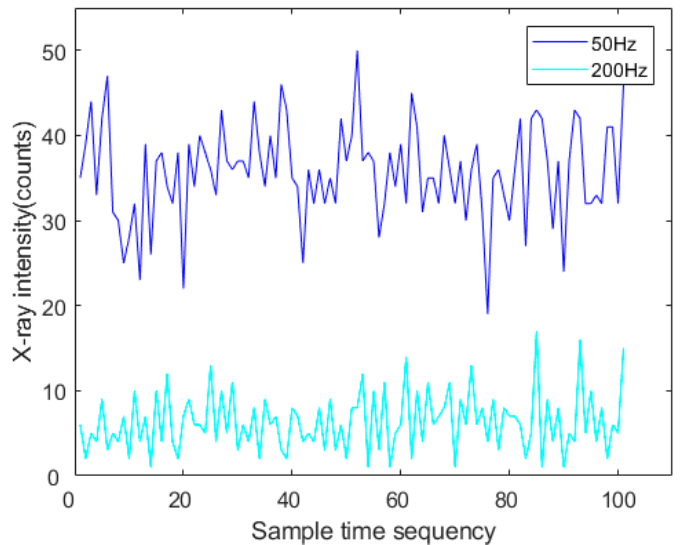
Figure 3. The original signals at different sampling frequencies in the same specimen position.